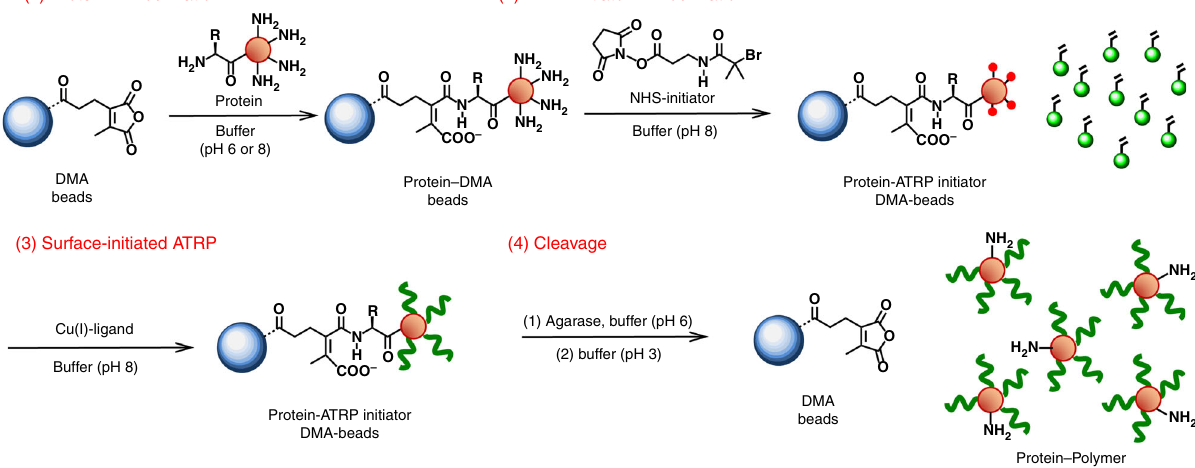
Fig. 1 Solid-phase synthesis of protein – polymer conjugates by protein-atom transfer radical polymerization on reversible immobilization supports (PARIS). Protein is fi rst immobilized onto DMA – agarose beads (at pH 6 – 8) through surface accessible primary amines. Remaining primary amines on the protein are then modi fi ed with ATRP initiators (NHS-Br), followed by surface-initiated ATRP, to create functional protein – polymer conjugates. The resulting protein – polymer conjugates are detached from the DMA – agarose beads below pH 6 and pass through a fi lter in pure